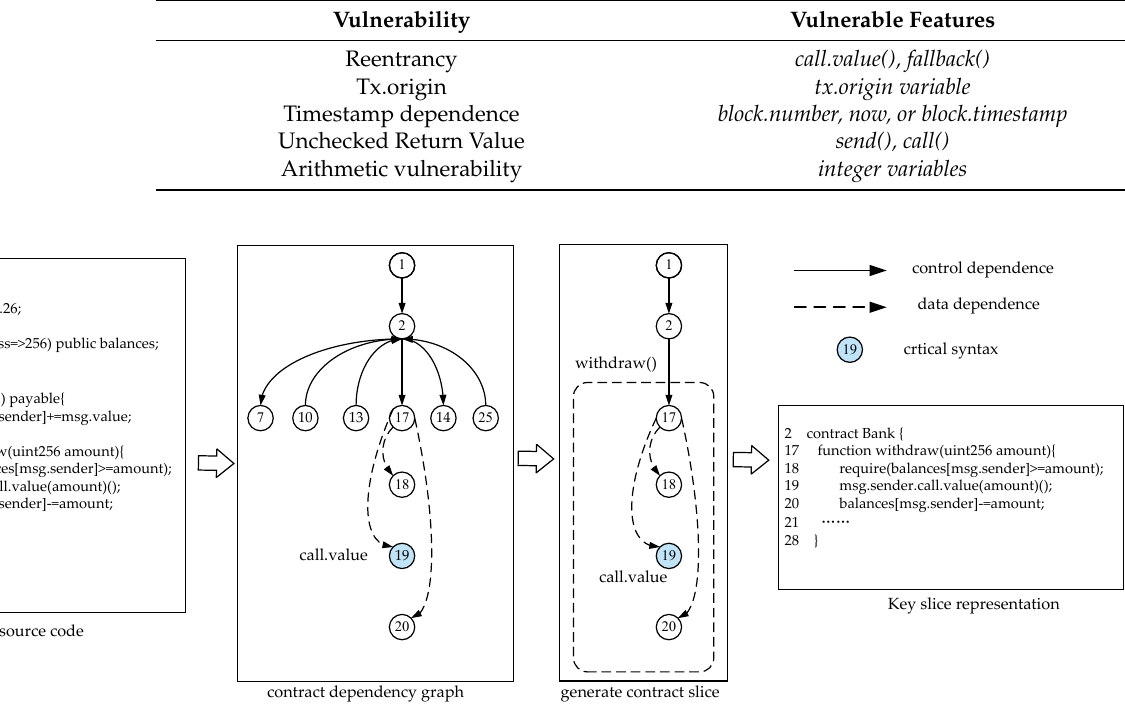
Figure 7. Extract code fragment.